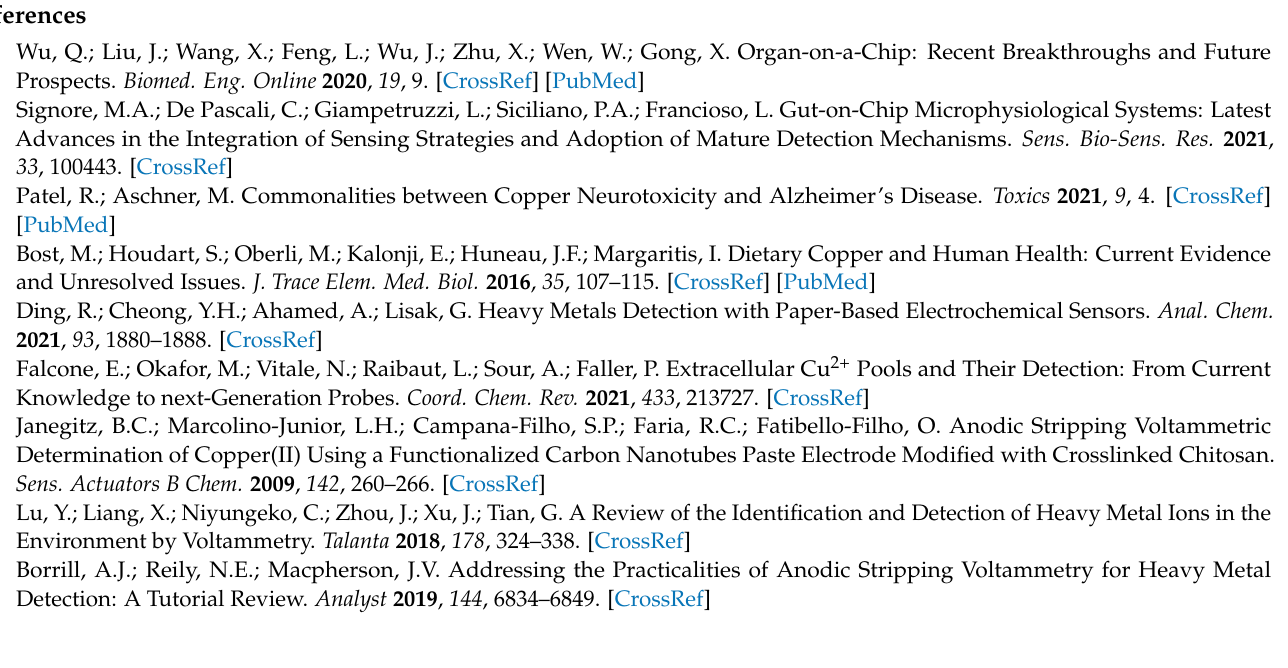
right) using DT as classifier; Figure S2: Confusion matrix for six classes of copper ions concentration in MEM at the same pH condition (pH 7.4 on the left, pH 4 on the right) using NB as classifier; Figure S3: Confusion matrix for six classes of copper ions concentration in MEM at the same pH condition (pH 7.4 on the left, pH 4 on the right) using SVM as classifier; Figure S4: Confusion matrix for six classes of copper ions concentration in MEM at the same pH condition (pH 7.4 on the left, pH 4 on the right) using ANN as classifier; Figure S5: Confusion matrix for twelve classes of copper ions concentration in DMEM at different pH conditions using DT as classifier; Figure S6: Confusion matrix for twelve classes of copper ions concentration in DMEM at different pH conditions using NB as classifier; Figure S7: Confusion matrix for twelve classes of copper ions concentration in DMEM at different pH conditions using SVM as classifier; Figure S8: Confusion matrix for twelve classes of copper ions concentration in DMEM at different pH conditions using ANN as classifier; Figure S9: Confusion matrix for twelve classes of copper ions concentration in F12 at different pH conditions using DT as classifier; Figure S10: Confusion matrix for twelve classes of copper ions concentration in F12 at different pH conditions using NB as classifier; Figure S11: Confusion matrix for twelve classes of copper ions concentration in F12 at different pH conditions using SVM as classifier; Figure S12: Confusion matrix for twelve classes of copper ions concentration in F12 at different pH conditions using ANN as